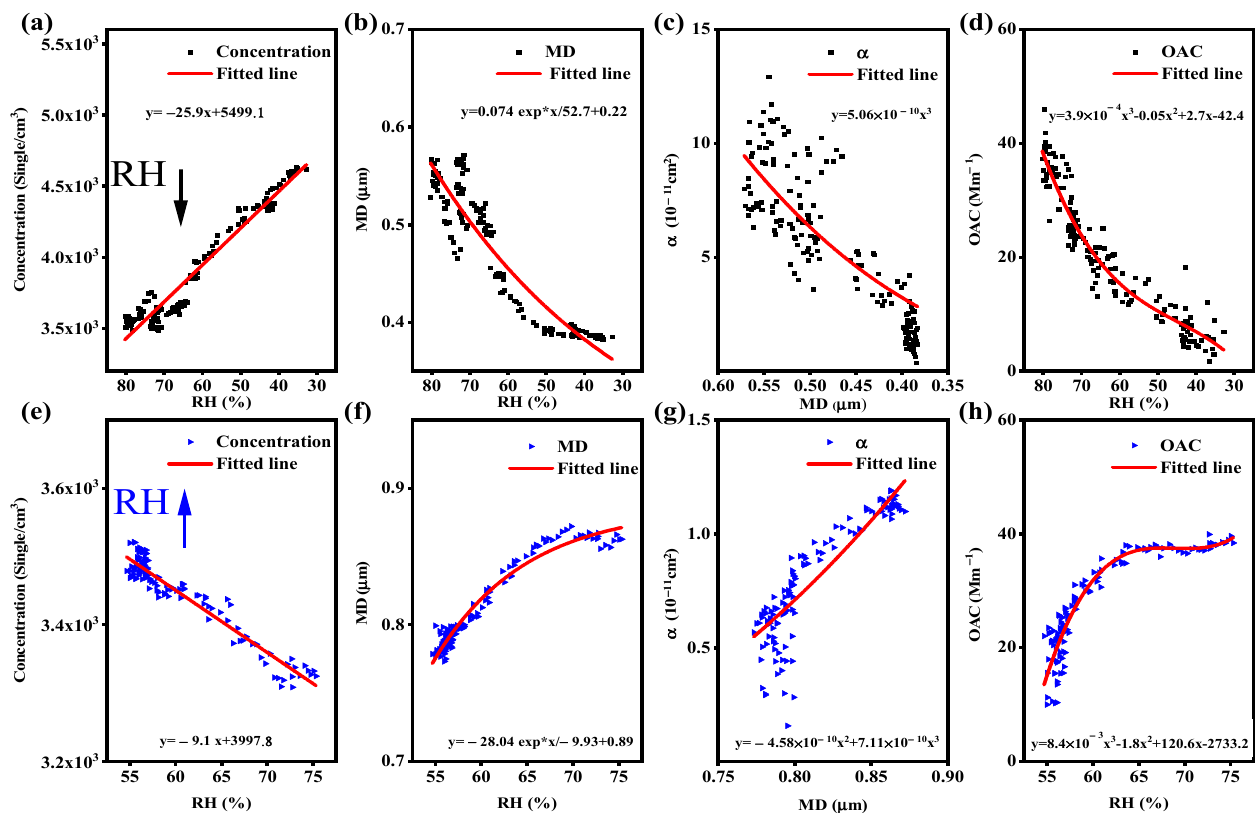
Figure 7. RH increase and decrease process: ( a , e ) change in particle number concentration with RH ; ( b , f ) change in particle mean diameter (MD) with RH ; ( c , g ) change in absorption cross section ( α ) with MD; ( d , h ) change in OAC with RH .